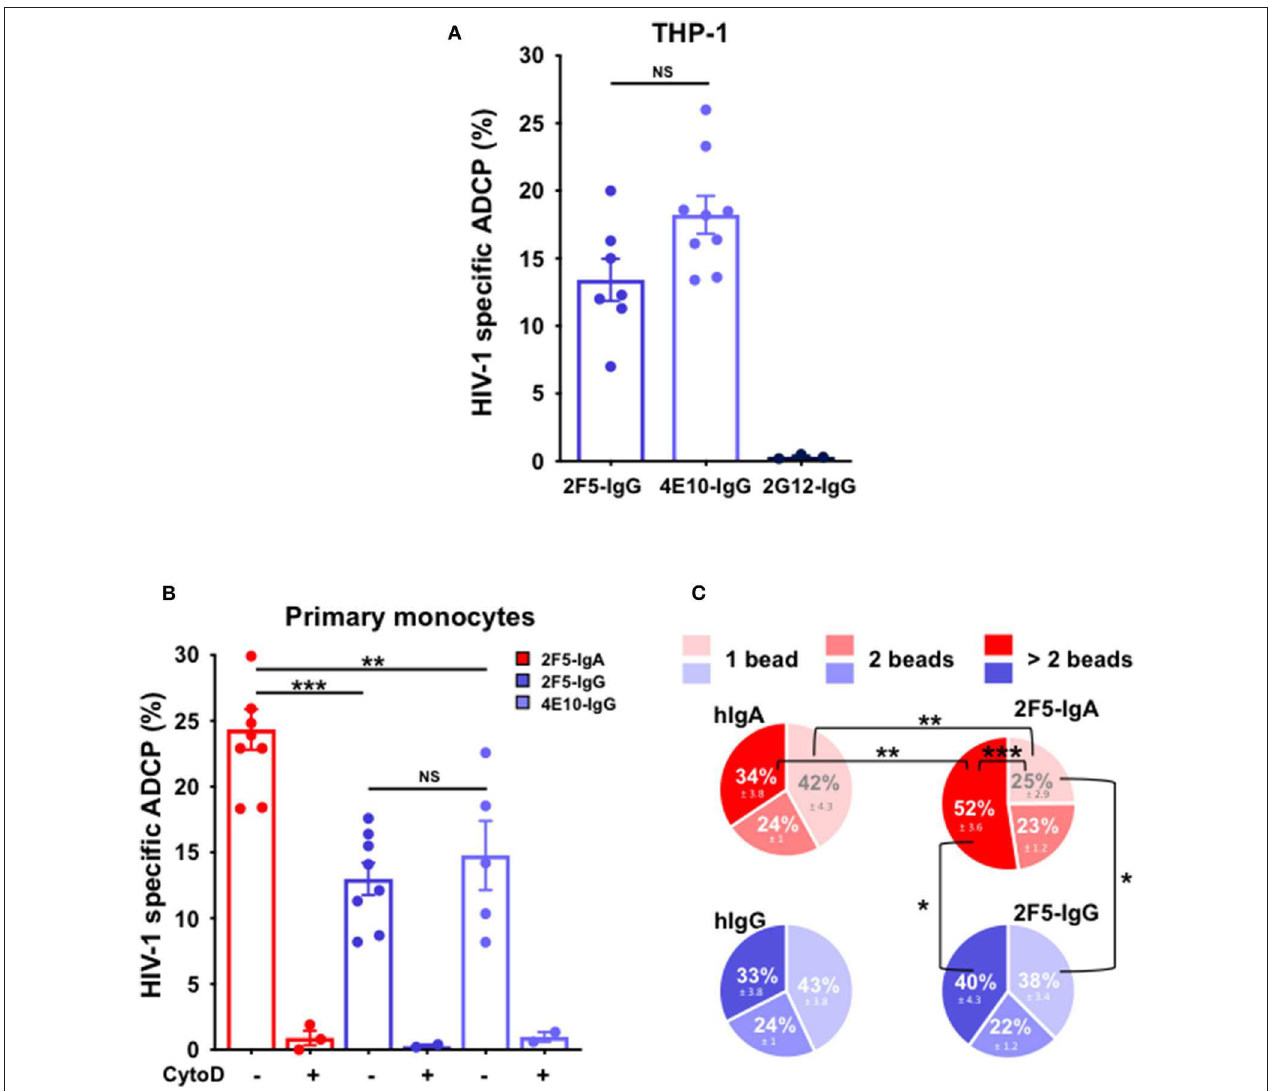
FIGURE 2 | Anti-gp41 2F5-IgA triggers more efficient ADCP of P1-coated beads compared to anti-gp41 2F5-IgG and 4E10-IgG in the ADCP-SHIP assay. Genuine ADCP of beads triggered by gp41-specific IgA and IgG was evaluated by the ADCP-SHIP method, discriminating surface-attached beads from actual intracellular phagocytosed beads. (A) ADCP-SHIP method validated using the monocytic THP-1 as effector cells. Fluorescent neutravidin beads coated with Cy5-labeled fluorescent internalization probe (FIP Cy5 ) and gp41 subunit P1 were incubated with anti-gp41 2F5-IgG (blue bar), and 4E10-IgG (light blue bar), anti-gp120 2G12-IgG (dark blue bar) or irrelevant human IgA2 or IgG prior to addition to the THP-1 effector cells for 3h at 37 ◦ C. Cy5 fluorescence of surface-bound beads was quenched by incubation with the complementary quenching probe (QP C ). ADCP was evaluated by flow cytometry and calculated as follows: % of FITC + Cy5 + cells with antibody—background % of FITC + Cy5 + cells without antibody. ADCP % in the presence of control human IgA/hIgG was subtracted from ADCP % triggered by HIV-1 specific antibody. Values represent means of P1-specific beads ADCP % ± SEM from 3 independent experiments performed in triplicate. NS: p > 0.05, unpaired Student’s t -test. (B) Primary monocyte-mediated ADCP is more efficiently triggered by 2F5-IgA than gp41-IgGs. 2F5-IgA (red bar), 2F5-IgG (blue bar) and 4E10-IgG (light blue bar) were assayed by the ADCP-SHIP method using primary monocytes as effector cells. When indicated, monocytes were pre-treated with 10 µ g/ml of Cytochalasin D (CytoD) for 30min at 37 ◦ C or left untreated and added to beads opsonized with the IgA/IgG Abs. Values represent means of P1-specific beads ADCP % ± SEM from at least 3 independent experiments performed in triplicate, NS p > 0.05, ** p < 0.01, *** p < 0.001, unpaired Student’s t -test. (C) Characterization of the efficiency of bead phagocytosis by ADCP-SHIP. The number of beads phagocytosed by each cell triggered by 2F5-IgA/IgG or the control hIgA/hIgG was evaluated from the intensity of Cy5 fluorescence associated to each cell. Light, median, or dark red/blue represent the percentage of cells having phagocytosed 1, 2, or > 2 beads (i.e., between 3 and 7). Values represent means of P1-specific ADCP distribution % ± SEM, from 3 independent experiments performed in triplicate, * p < 0.05, ** p < 0.01, *** p < 0.001, unpaired Student’s t -test.